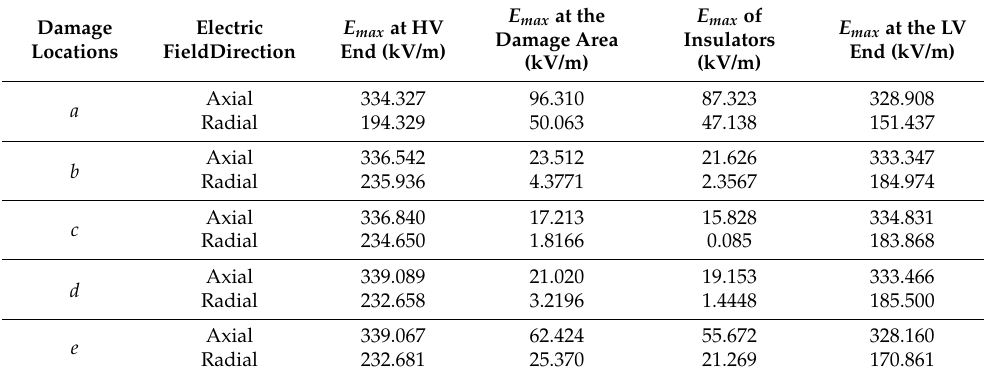
Table 3. Calculation results of the electric field on the surface of the damaged composite